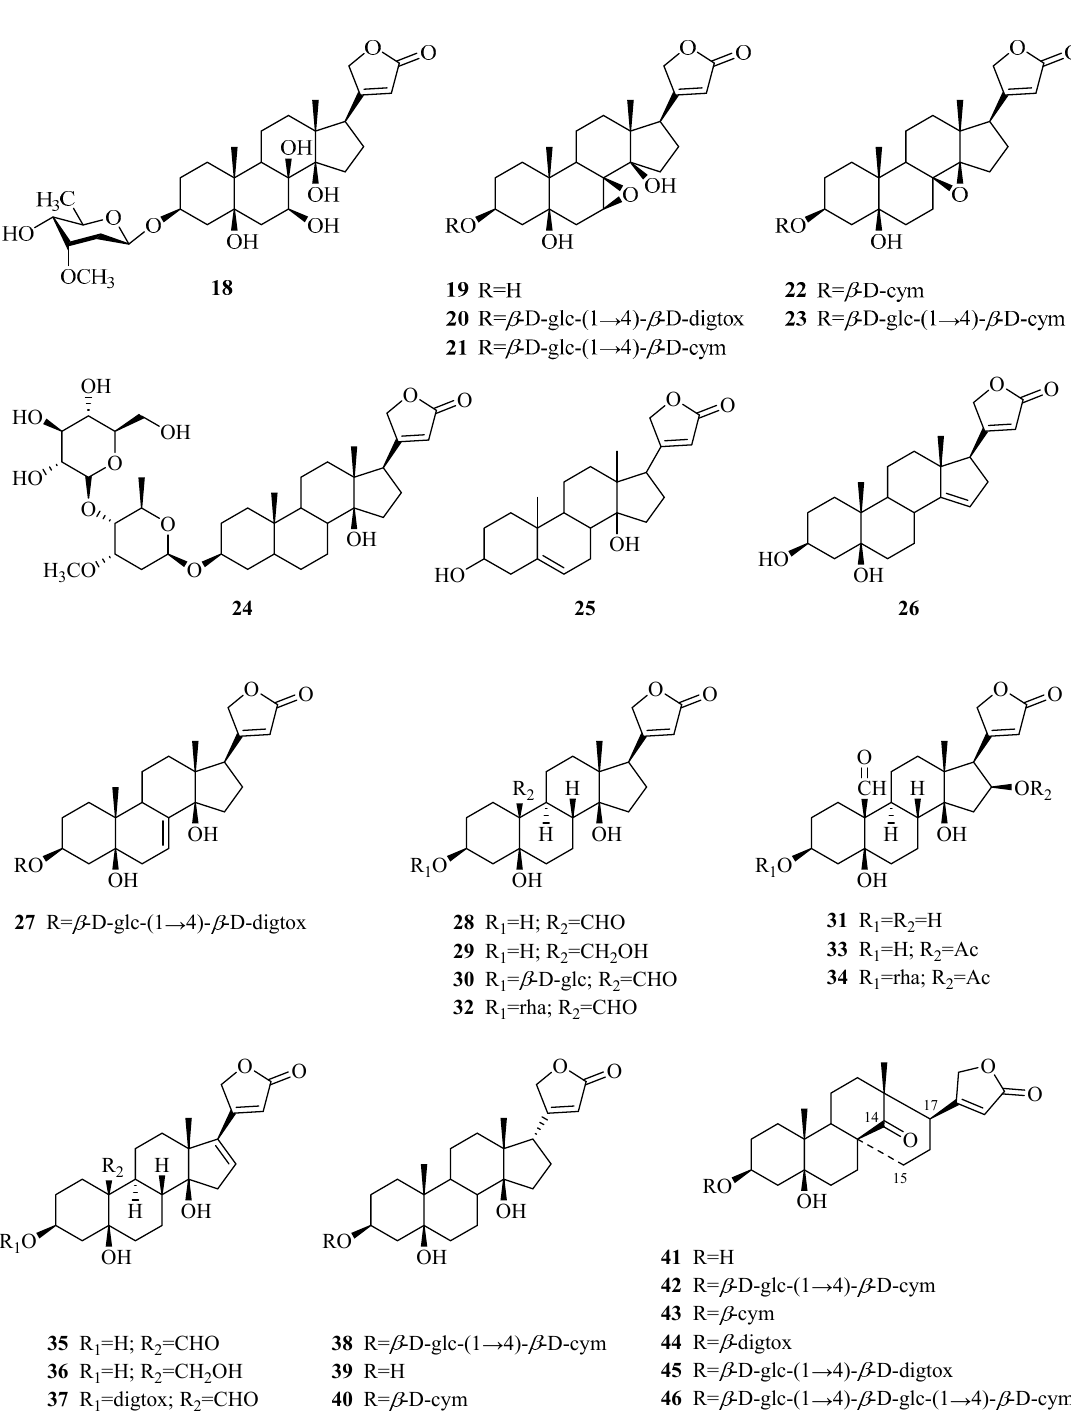
Figure 2. Cardenolide-type steroids from the genus Periploca .